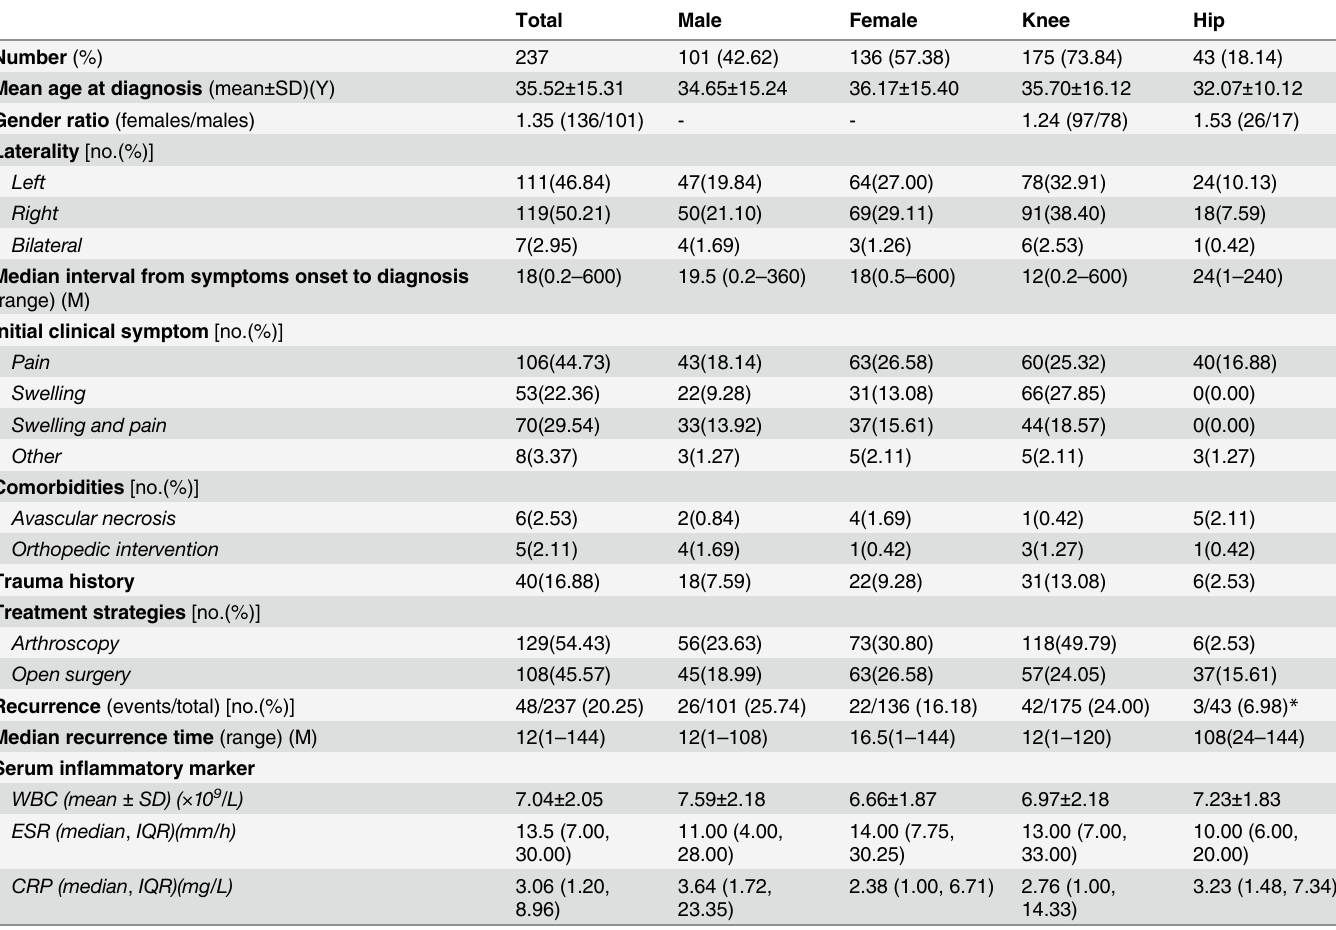
Table 1. Clinical and laboratory features of studied PVNS